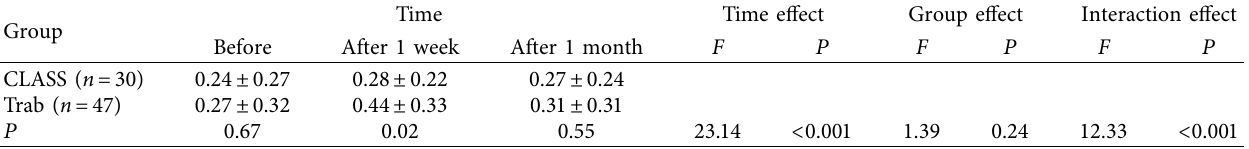
Table 2: Changes in BCVA in two groups before and after the